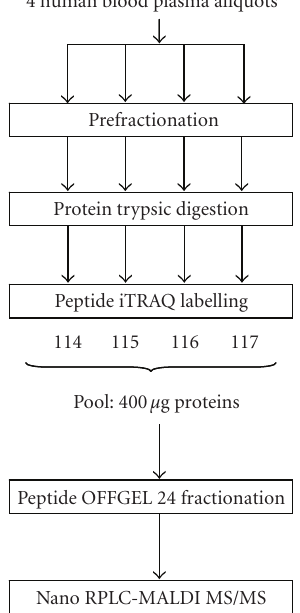
Figure 1: Illustration of the